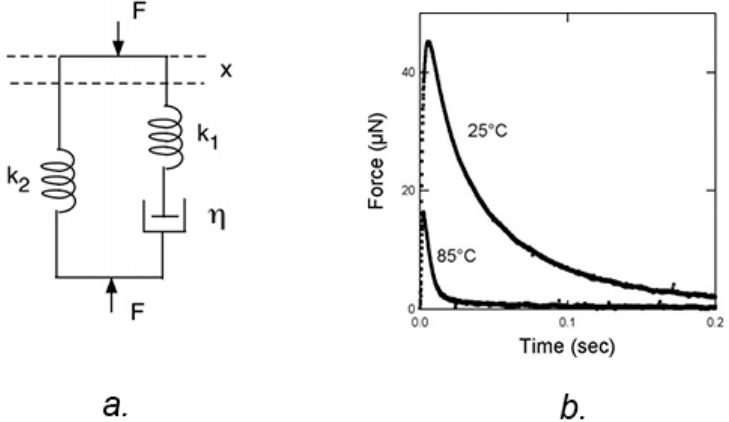
Figure 2. Rheological model of Silly Putty ( a ); dependence of relaxation on time ( b ).